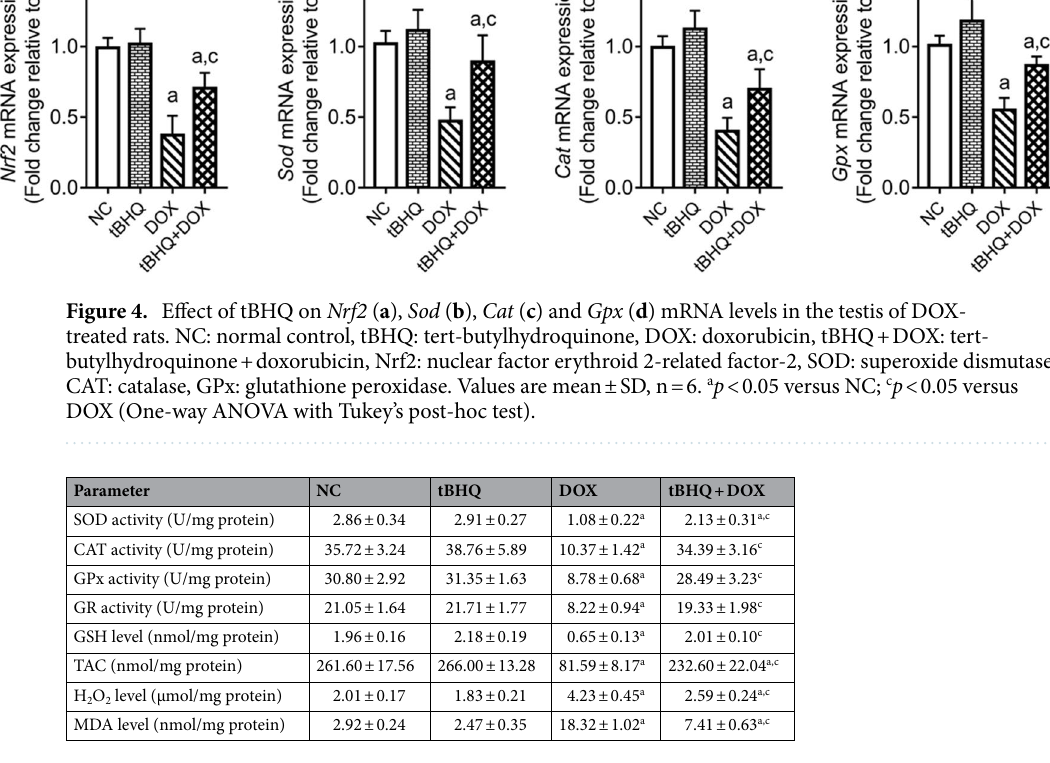
Table 3. Testicular antioxidant/oxidant parameters in the different experimental groups. Values are mean ± SD, n = 6/group. NC: normal control, tBHQ: tert-butylhydroquinone, DOX: doxorubicin. a p < 0.05 versus NC group, c p < 0.05 versus DOX group (One-way ANOVA with Tukey’s post-hoc test).